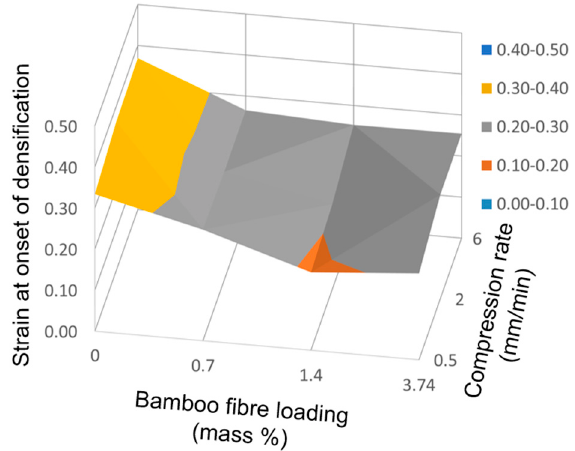
Figure 10. Surface plot showing variation of strain at onset of densification with compression rate and bamboo fiber loading.